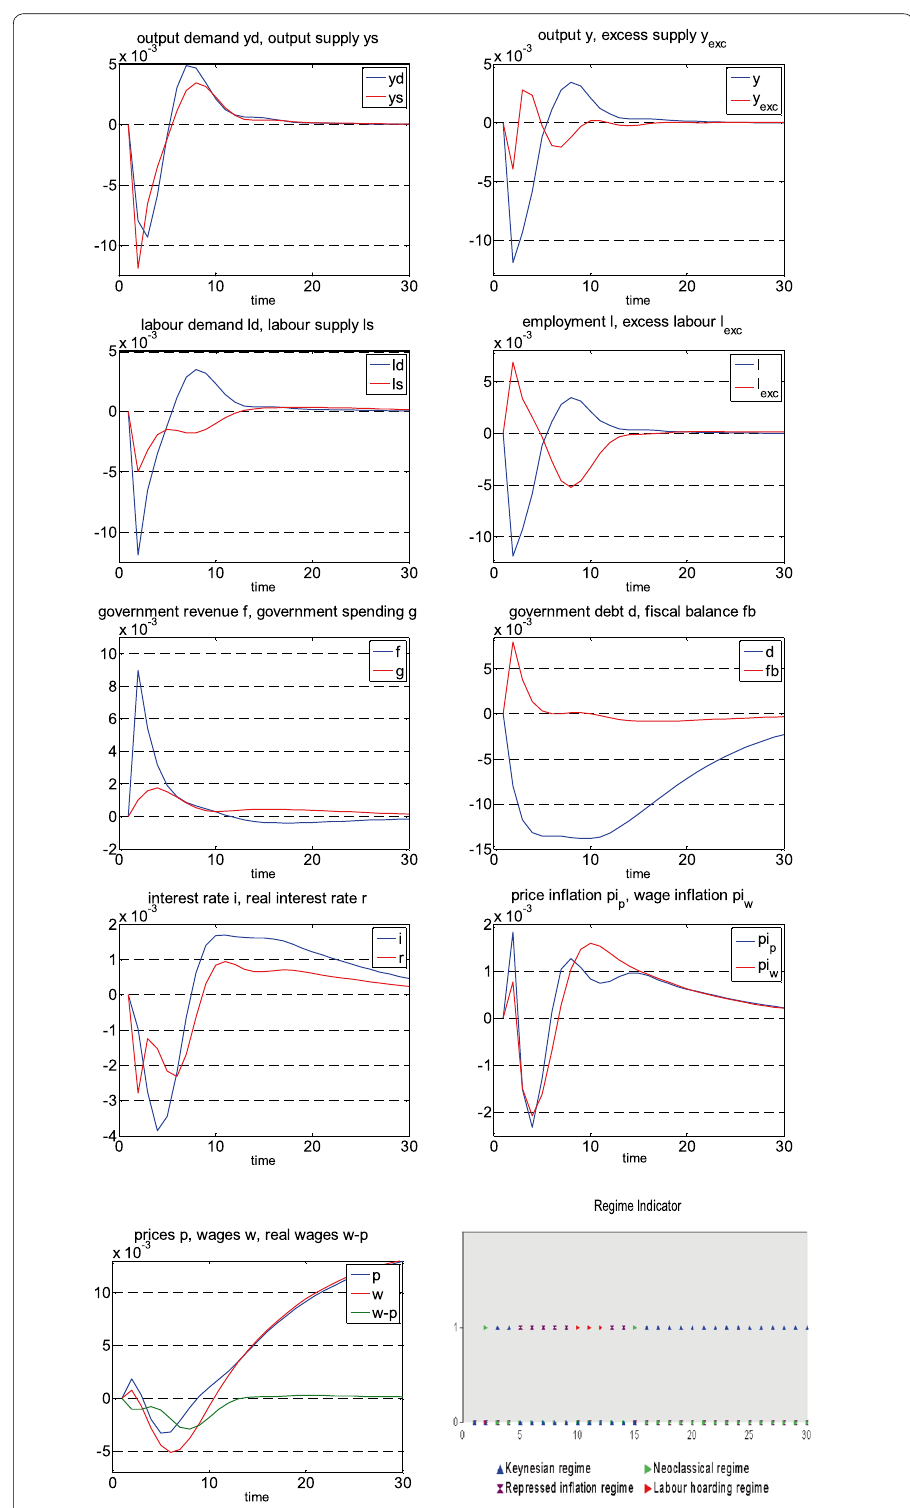
Fig. 1 Effects of a one-time positive government revenue